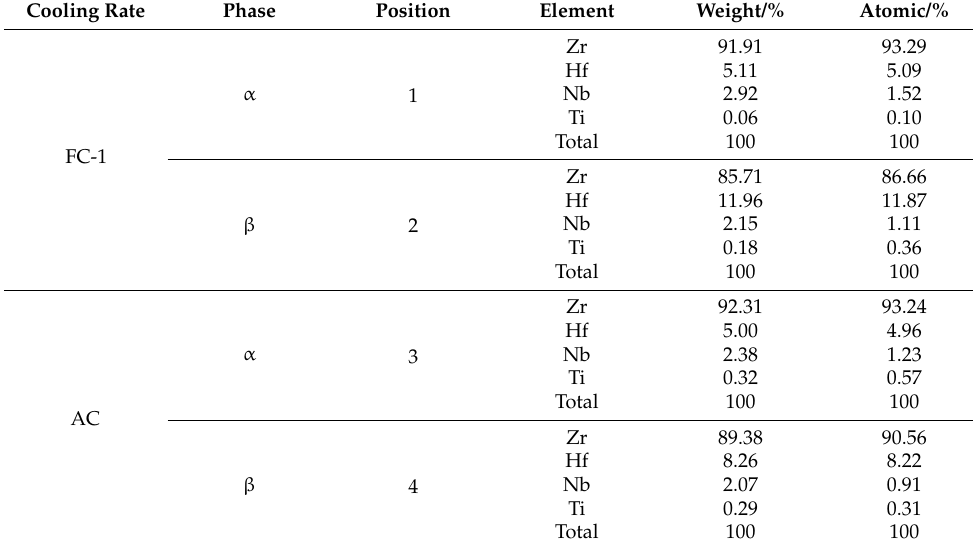
Figure 6. SEM micrographs of Zr-4Hf-3Nb (wt%) alloy with various cooling rate: ( a ) FC-1, ( b ) FC-2, ( c ) FC-3, ( d ) AC, ( e , f ) WC. Table 3. EDS analysis of the position 1, 2, 3, and 4 in Figure